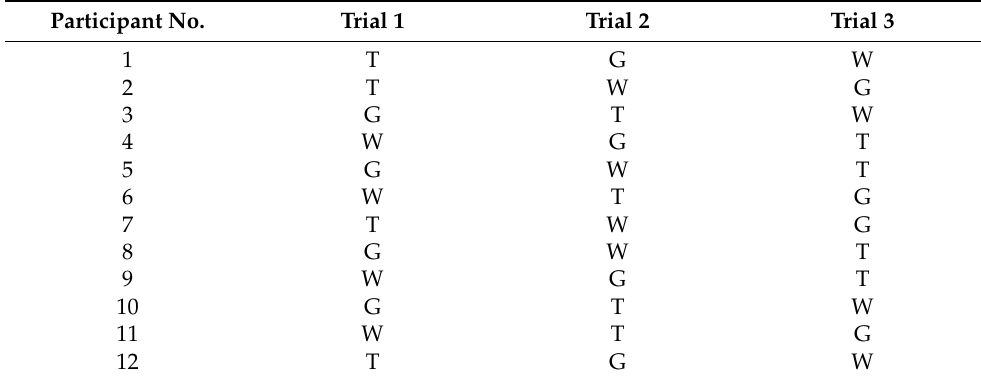
Table 2. Experimental design—participant numbers and randomized crossover trials.